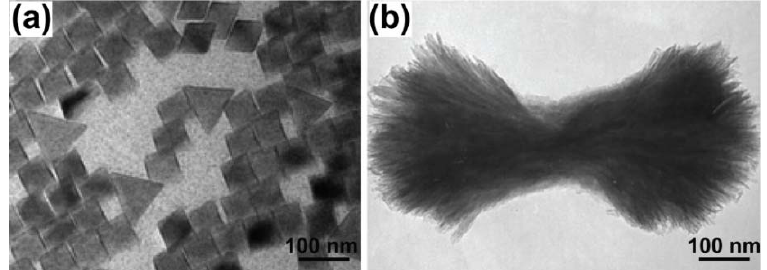
Figure 6. TEM images of ( a ) YF 3 nanophosphors prepared in the NP-5 stabilized microemulsion system. Reproduced from [74]. Copyright 2005, American Chemical Society. ( b ) YF 3 nanobundles synthesized in the CTAB and NP-5 stabilized microemulsion system. Reproduced from [75]. Copyright 2008, American Chemical